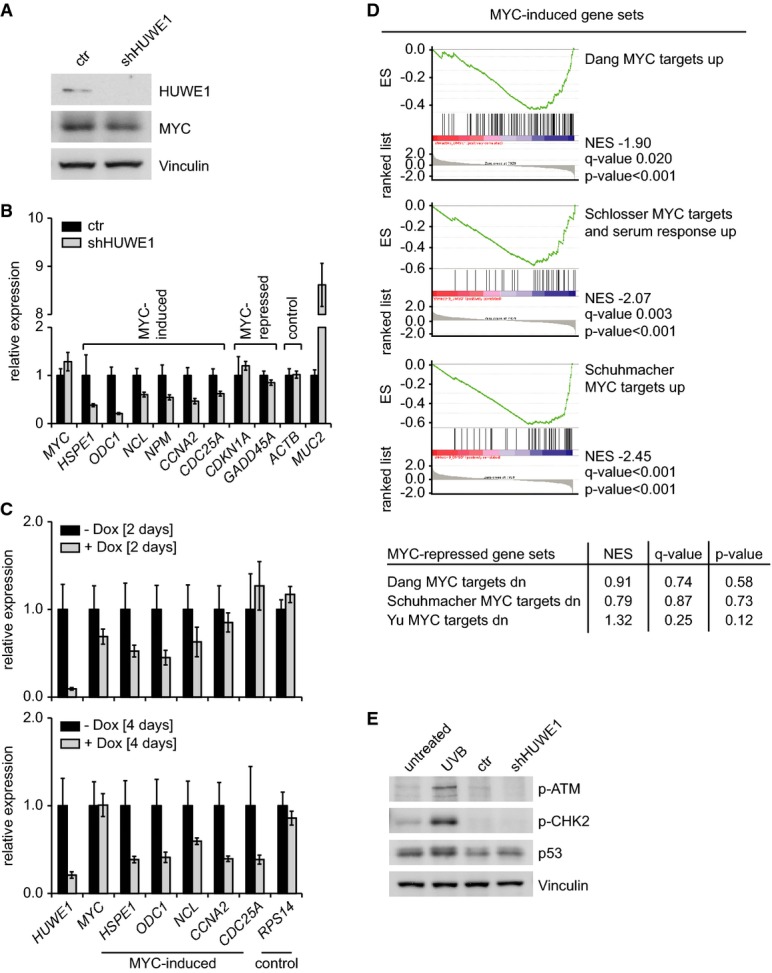
Effect of HUWE1 depletion on expression of MYC target genesExpression of MYC in HUWE1-depleted Ls174T cells. Ls174T cells were stably infected with
retroviruses expressing shRNA targeting HUWE1. After selection, cells were harvested and immunoblots
of cell lysates were probed with indicated antibodies.RQ–PCR assays documenting expression of the indicated genes in Ls174T cells expressing
control shRNA or shRNA targeting HUWE1. Error bars show SD of triplicate technical assays from one
representative experiment (n = 5).RQ–PCR assays documenting expression of the indicated genes in Ls174T cells expressing
doxycycline-inducible shRNA targeting HUWE1 at two different time points after addition of
doxycycline. Error bars show SD of triplicate technical assays from one representative experiment
(n = 2).Effects of HUWE1 knockdown on expression of previously identified sets of MYC target genes. The
upper panel displays results of a gene set enrichment analysis (GSEA), in which known sets of
MYC-induced genes from the Molecular Signature Database (MSigDB) are compared to genes regulated by
HUWE1 depletion in Ls174T cells. The table below shows examples of MYC-repressed gene sets.Effects of HUWE1 knockdown on p53 levels and DNA damage. The experiment was performed as
described in (A). As control, Ls174T cells were left untreated or exposed to
500 J/m2 UVB and harvested 3 h later.